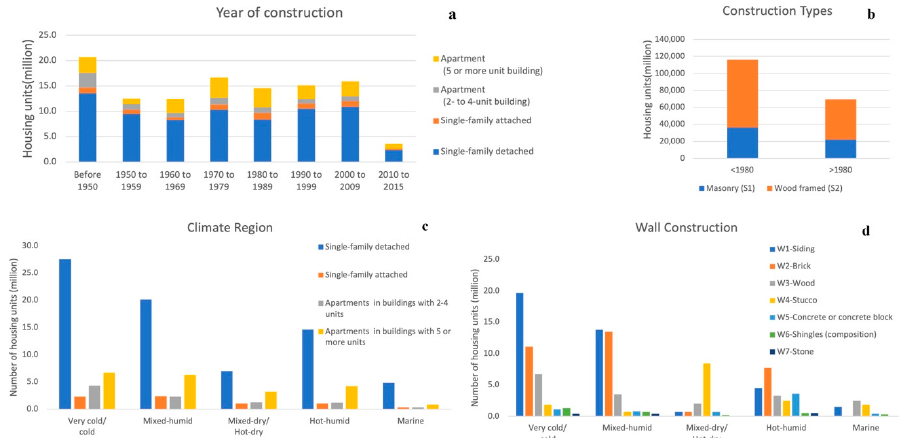
Figure 3. US residential building stock characteristics: ( a ) building age, ( b ) construction type, ( c ) housing stock segmentation per climate region, and ( d ) exterior wall types.